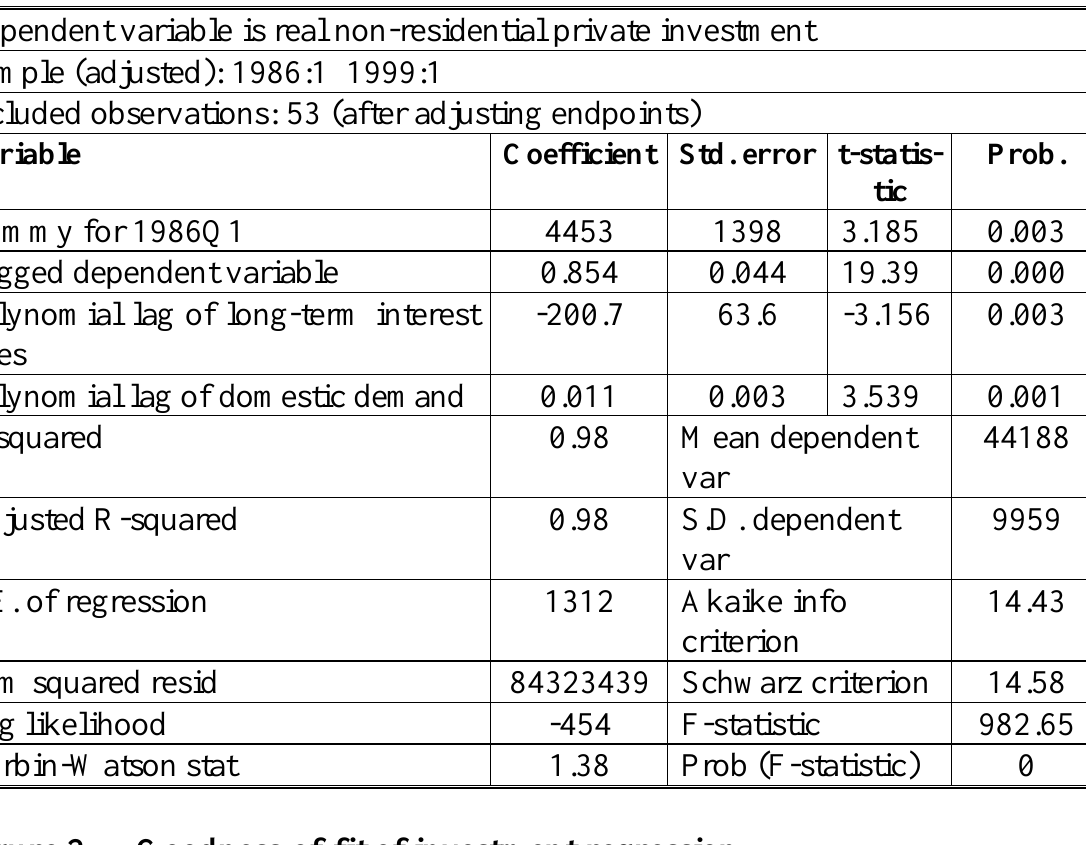
Goodness-of-fit of investment